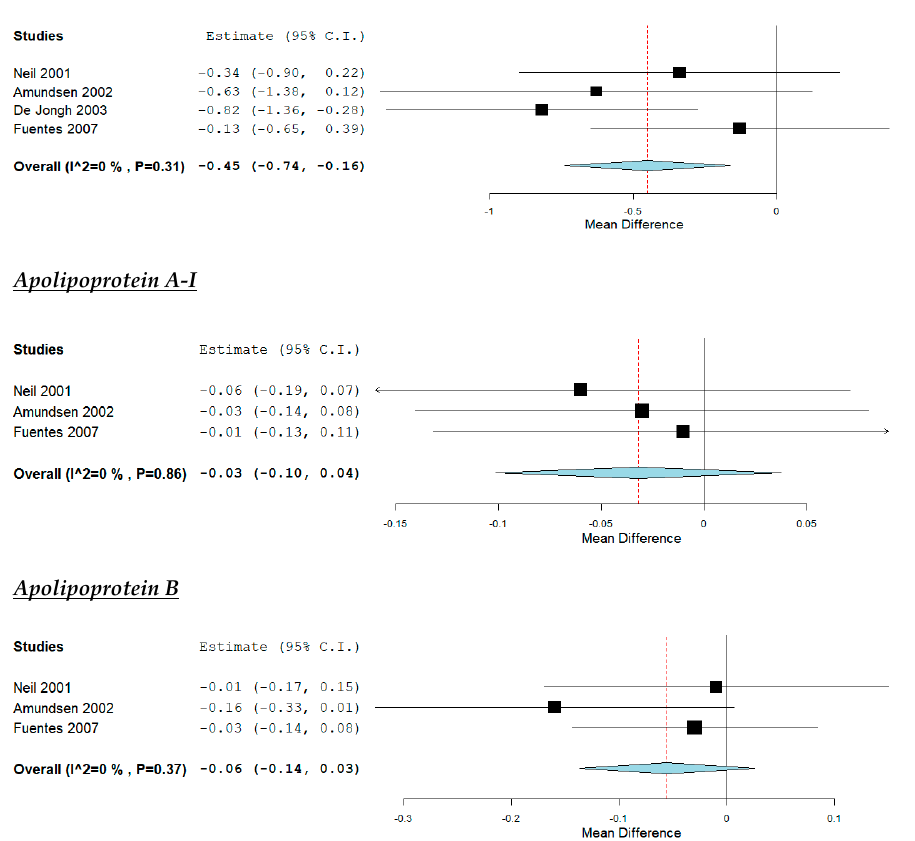
Figure 5. E ff ect of increased intake of plant sterols compared with Figure 5. Effect of increased intake of plant sterols compared with placebo.